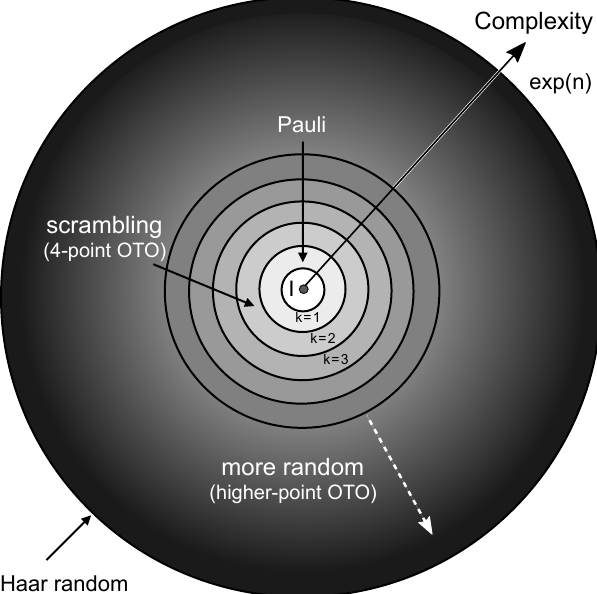
Figure 3 . A cartoon of the unitary group, with operators arranged by design. We pick the identity operator to be the reference operator of zero complexity and place it at the center. Typical operators have exponential complexity and live near the edge. Operators closer to the center have lower complexity, which makes them both atypical and more physically realizable in a particular computational model.